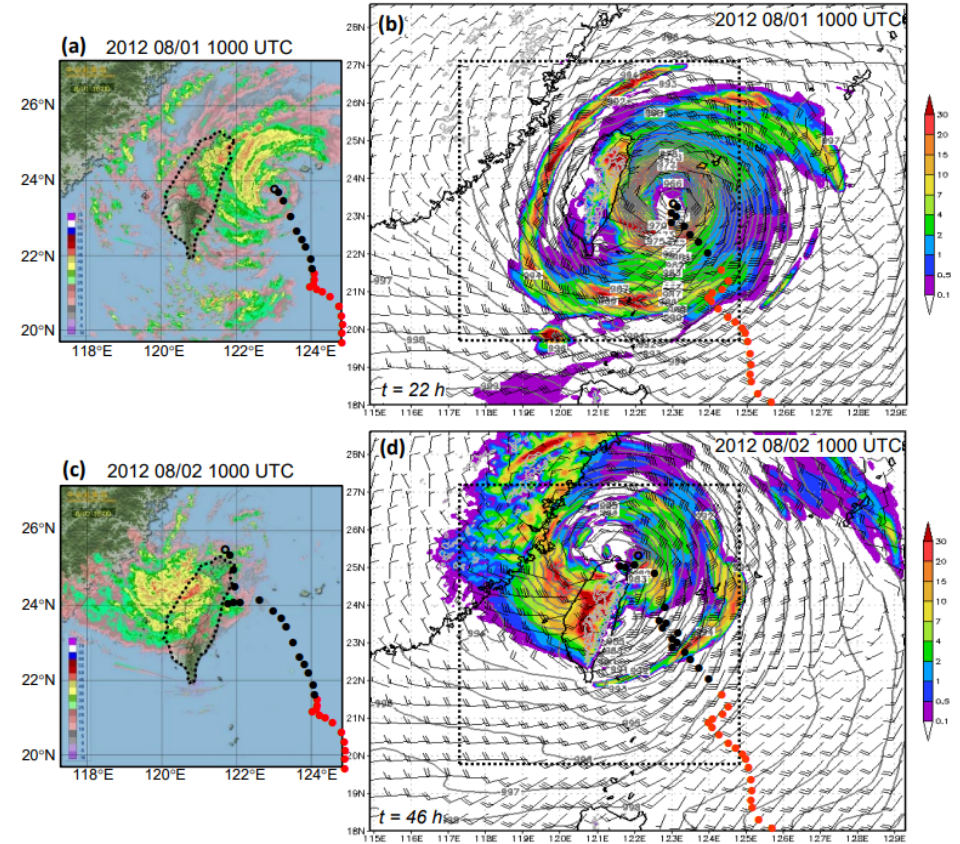
Figure 3. ( a ) Radar VMI reflectivity composite (dBZ, scale on top, every 5 dBZ from − 10 to 75 dBZ) at 1000 UTC 1 August (provided by the CWB) and ( b ) CReSS forecast ( t 0 at 1200 UTC 31 July) of sea-level pressure (hPa, every 1 hPa, over ocean only), surface wind (kts, barbs) at 10-m height, terrain elevation (gray contours at 1 and 2 km, over land only), and 1 h rainfall (mm, color, scale to the right) valid at the same time as ( a ). ( c , d ) As in ( a , b ) but for radar reflectivity at 1000 UTC 2 August and CReSS forecast valid at the same time as ( c ). The current typhoon center is marked by an open dot, and the earlier positions every 3 h (at 0000, 0300 UTC, etc.) by solid dots (in red prior to 1200 UTC 31 July). The dotted box in ( b , d ) corresponds to the region of radar plots. The 24 h rainfall distributions in Taiwan from rain gauges for three periods starting from 1200 UTC of 30 and 31 July and 1 August are presented in Figure 4 (left column). In the first two segments, the observed rainfall was mainly in northeastern and eastern Tai- wan, with peak amounts near the northern end of the CMR (Figures 1a and 4a,e) as the prevailing wind from the TC was northeasterly (cf. Figure 3b). When Saola moved closer to landfall after 1200 UTC 1 August, the rainfall in Taiwan increased dramatically, with a 24 h peak amount of 889 mm again at the northern end of the CMR (Figure 4i), and the prevailing winds gradually turned into northwesterly and westerly (cf. Figure 3b,d) such that the western part of the island also received much rainfall. During the next 24 h period, the rainfall in Taiwan reduced significantly (not shown) as Saola moved away and made landfall in China (Figure 1b). Clearly, this storm produced the most rainfall during the 24 h period from 1200 UTC 1 to 1200 UTC 2 August (Figure 4i), so the model’s QPFs valid for this period at different lead times are our main focus.